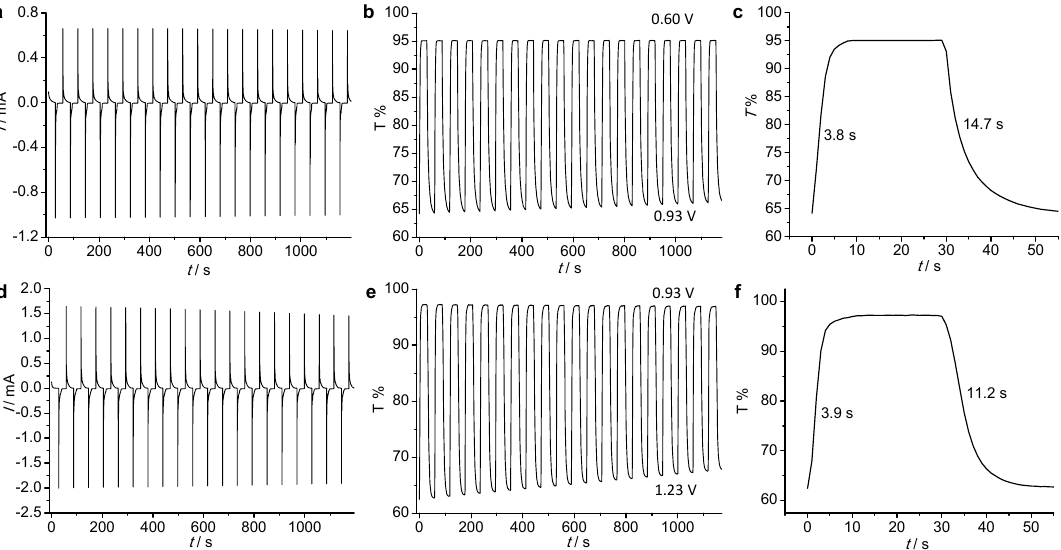
Figure 5. Electrochromic switching of P1 between ( a – c ) +0.60 and +0.93 V vs Ag/AgCl and ( d – f ) between +0.93 and +1.23 V in 0.1 M n Bu 4 NClO 4 /ClCH 2 CH 2 Cl. ( a , d ) Current assumption. ( b , c ) Transmittance changes monitored at 1450 nm. ( e , f ) Transmittance changes monitored at 776 nm.